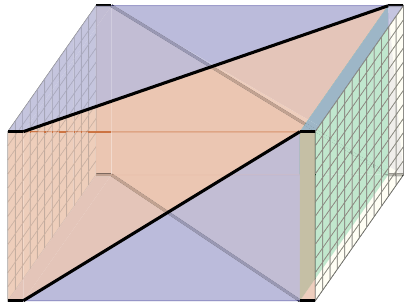
FIG. 22. Logical template for a Hadamard gate based on the (Kitaev-style) planar code. Note that, while this geometry of pla- nar code uses twice as many qubits than the Wen-style geometry to encode a qubit for a given distance, the volume of this gate is less than the version depicted in Fig. 6 for a fixed fault